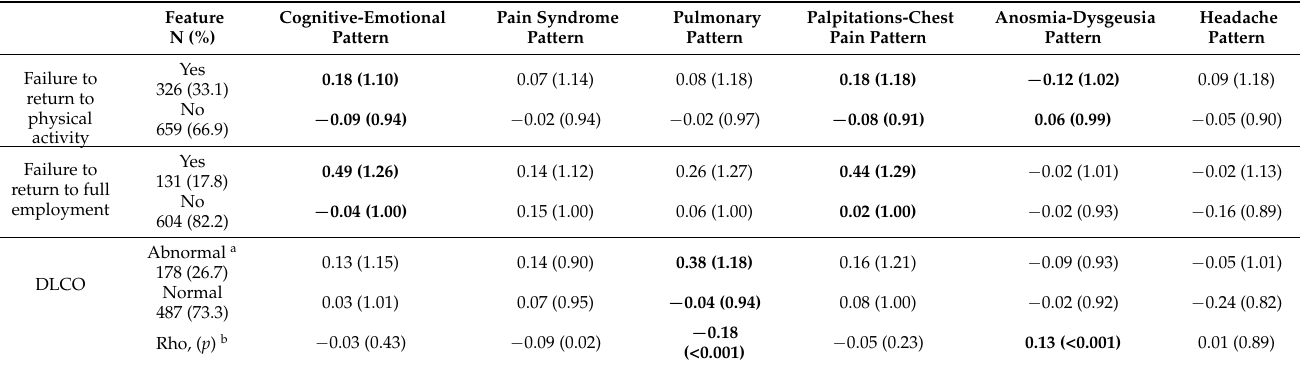
Table 3. Patterns associations with patient outcomes at clinic visit. Means for each of the patterns with standard deviation in parenthesis are shown. Significant associations ( p < 0.05) marked in bold. Analysis by t -test (Spearman where